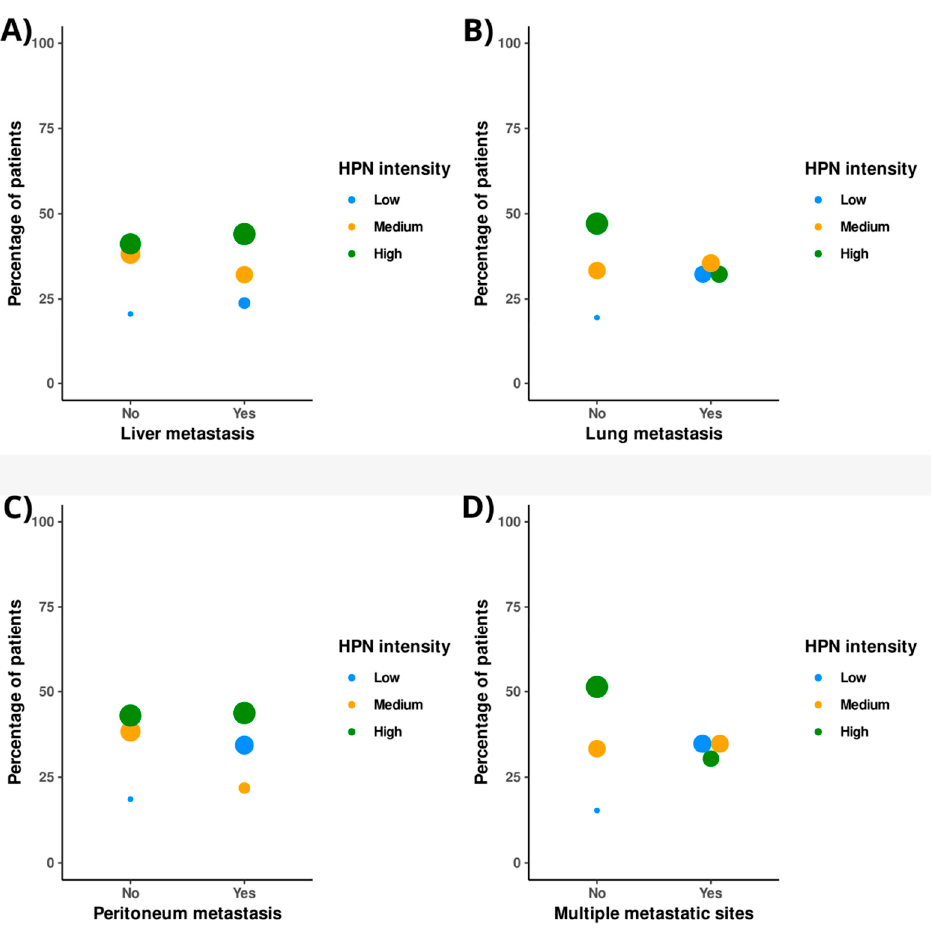
Figure 5. Distribution of hepsin staining intensity in patients with different metastatic involvement at diagnosis of cancer. ( A ) Liver metastasis. ( B ) Lung metastasis. ( C ) Peritoneal metastasis. ( D ) More than one metastatic location. HPN: Hepsin.